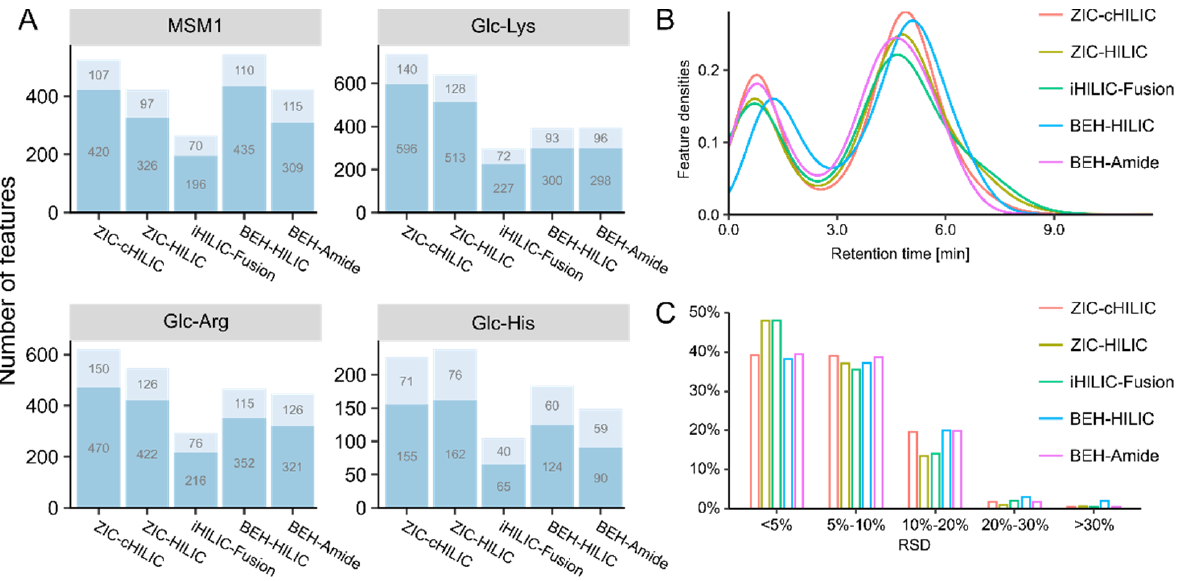
Figure 2. Results of column selection. ( A ) Bar plots representing the number of features detected by different columns in each model system. Features were categorized into two types: features with MS2 (light blue) and features without MS2 but recognizable extracted ion chromatograms (dark blue). MSM1: the model systems mixture of twenty ‐ one amino acids. ( B ) Retention time distribution of all detected features in model systems. ( C ) Relative standard derivation (RSD) distribution of all feature intensities.